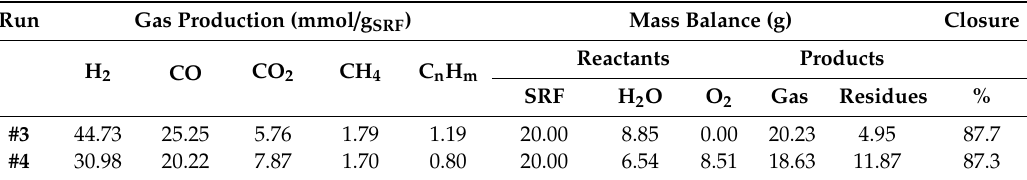
Table 5. Gas yield and mass balance closure for SRF gasification.